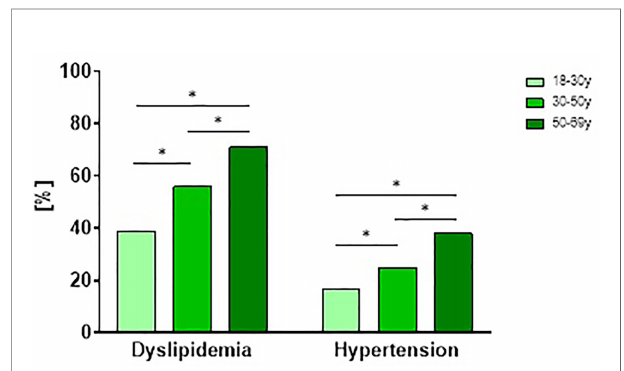
FIGURE 5 | Prevalence and management of hypertension and dyslipidemia in patients with newly diagnosed type 1 diabetes strati fi ed by age. Prevalence and management of modi fi able cardiovascular risk factors (dyslipidemia and hypertension) strati fi ed by age tertiles in participants with newly diagnosed type 1 diabetes from the GDS and DPV cohort. P values refer to comparison of unadjusted data. *p < 0.05 regarding the prevalence of